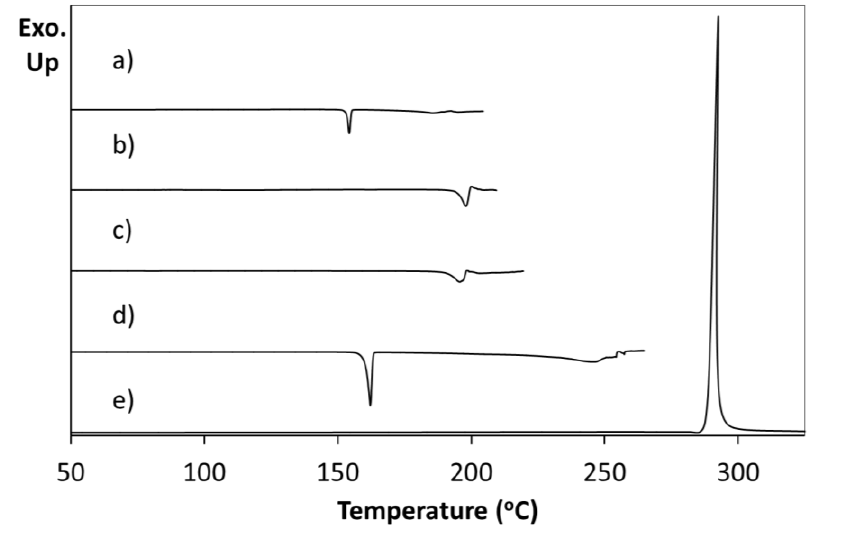
Figure 16. Differential scanning calorimetry of products from cooling crystallisations using the Crystal16 involving 5FC-4Cl35DNBA 5FC:4Cl35DNBA in ethanol:water (7:3 by volume) in a: ( a ) a 1:2 ratio (0.5 °C min −1 ); ( b ) a 1:2 ratio (2 °C min −1 ); and ( c ) a 1:1 ratio (2 °C min −1 ); ( d ) 4Cl35DNBA; ( e )